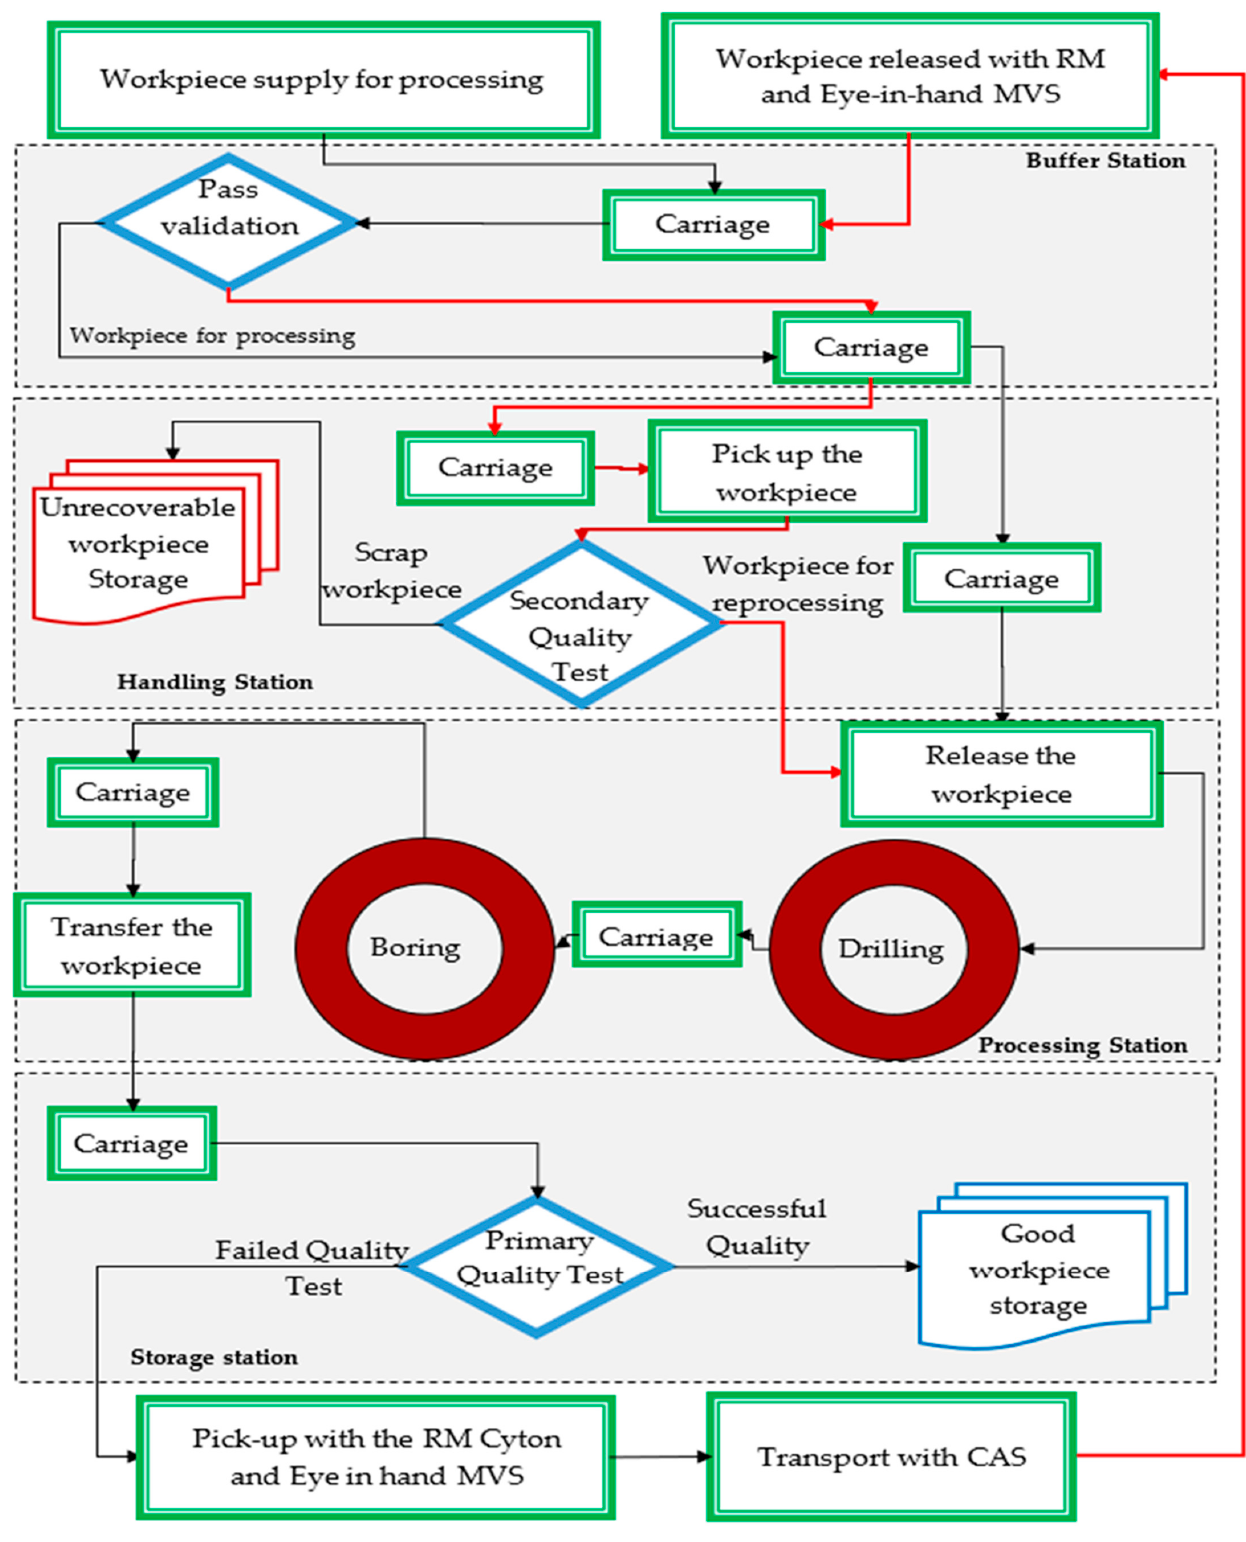
Figure 5. Processing/Reprocessing cycle for a piece that has failed the quality test. Because the P/RML on its basis is a flexible industrial production line, it is designed to easily adapt to changes in the type and quantity of the product and it has a high range